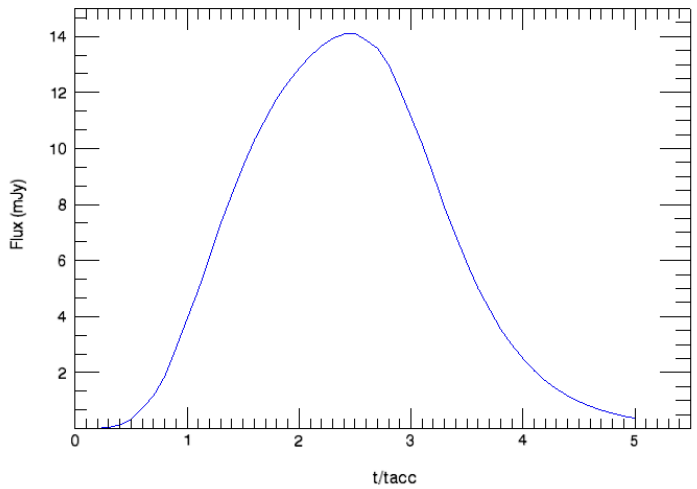
Figure 5. The pulse shape for a shock moving at 1c encountering a density enhancement with the following parameters: B = 2 Gauss, Q = 609.3 m 3 s − 1 , ν = 4.3 × 10 14 , t f = 2.5/t acc .